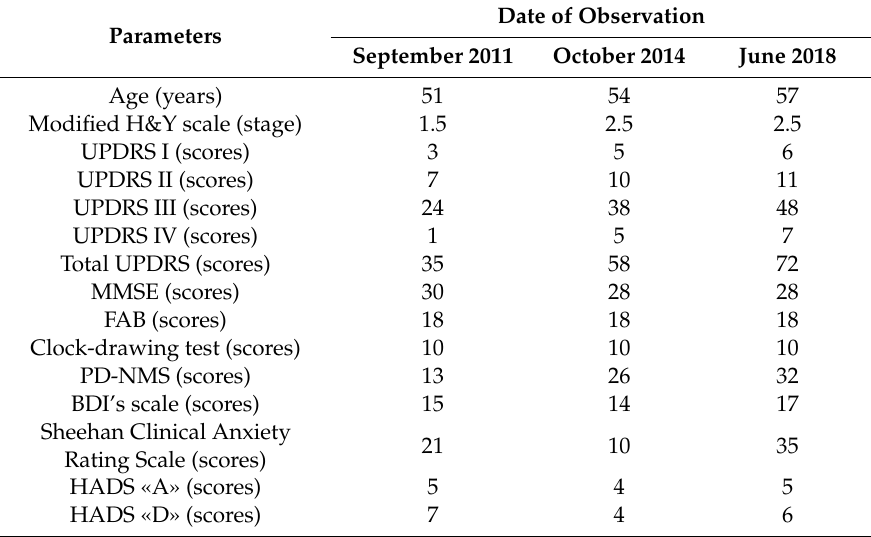
Table 1. Parkinson’s disease clinical manifestation dynamics in patient M.